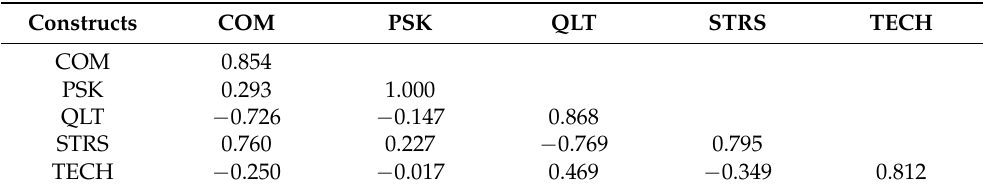
Table 5. The Fornell–Larcker criterion.